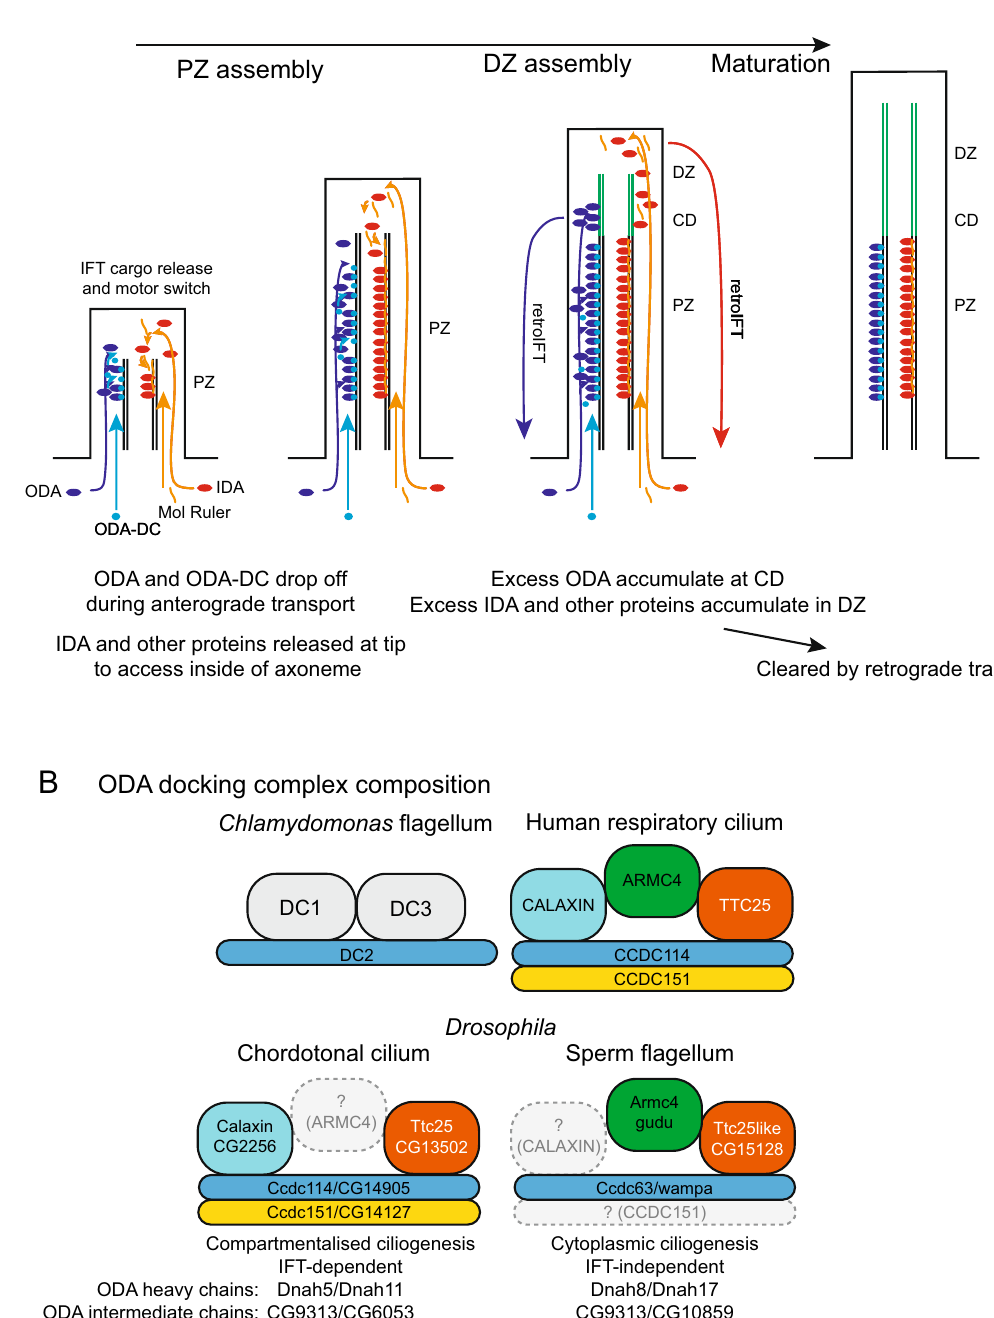
Figure 8. Models of dynein transport in chordotonal ciliogenesis and of ODA-DC composition. ( A ) ODA and ODA-DC are able to access their microtubule binding sites along the length of the proximal zone (PZ). They are released from IFT trains before they reach the ciliary tip. Consequently, as the distal zone (DZ) extends, excess complexes are not found far beyond the proximal zone—transient accumulation occurs at the future ciliary dilation (CD). In contrast, IDA, their docking proteins, and other components access their microtubule binding sites at the growing tip only, and are released from IFT trains at the tip. Excess complexes accumulate transiently in the distal zone. In all cases, we envisage that excess complexes (not stably bound to the PZ) are eventually cleared by retrograde IFT. ( B ) Schematic of the proposed composition of Drosophila ODA-DC complexes, relative to the counterparts in Chlamydomonas flagella and human respiratory cilia. Colour coding indicates homology. Expression and functional evidence strongly suggest the presence of substantially different ODA-DCs in chordotonal cilia compared with sperm flagella. These differences may be related to differences in mode of ciliogenesis or in differences in ODA subunit